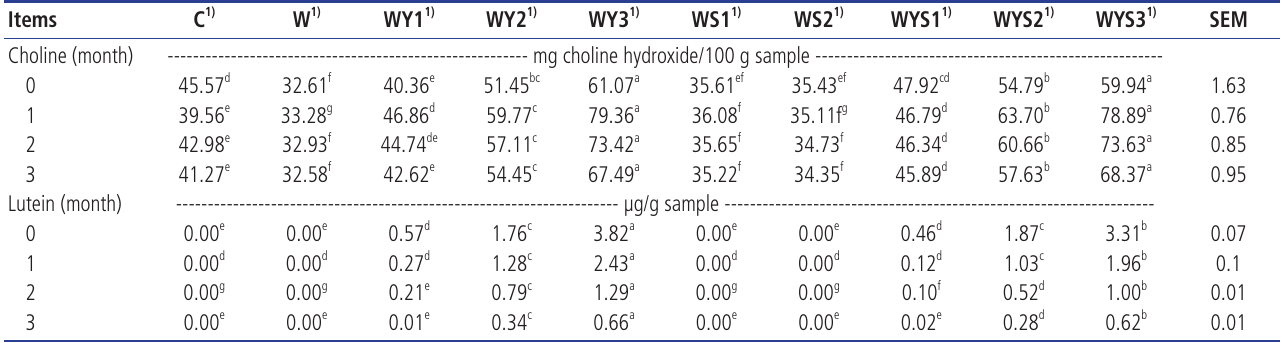
Table 4. Choline and lutein contents of non-dairy creamers with different formula and storage time Items C 1)